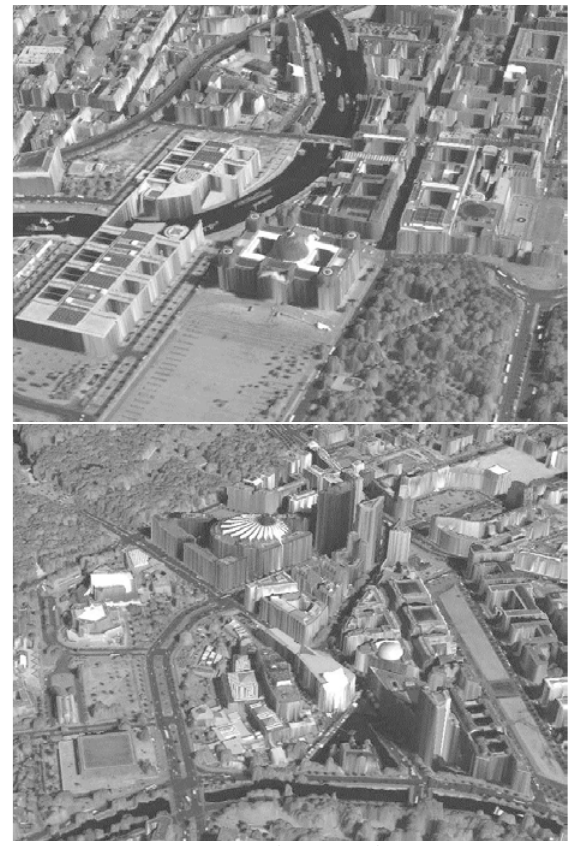
Figure 4: Reconstruction of a part of Berlin, textured by panchromatic